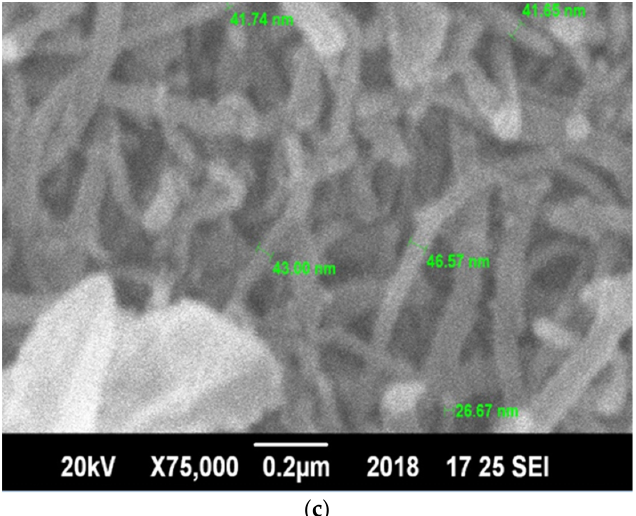
Figure 12. Scanning electron micrographs of synthesized CNTs at different magnifications mentioned on each subfigure ( a – c ).